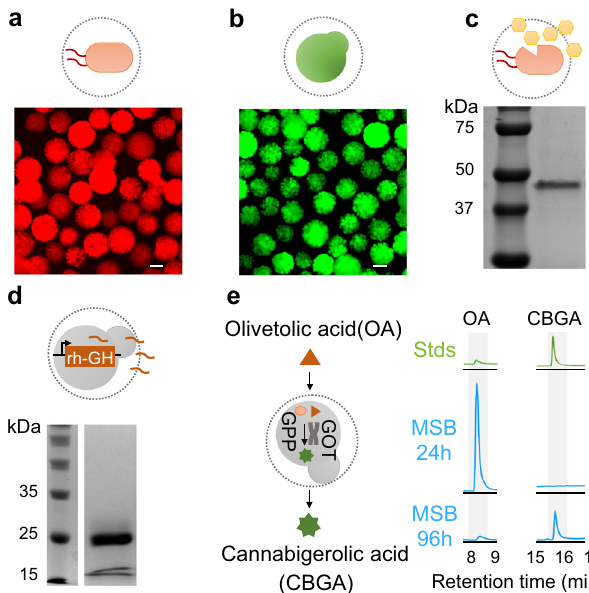
Fig. 2 Microbial swarmbot supported the growth of various microbes and produced versatile proteins and small molecules. a The growth of engineered E. coli was supported in microbial swarmbot (MSB). MG1655 cells (constitutively producing mCherry) were encapsulated in chitosan capsules and cultured in the SC + LB medium at 30 °C. Images were taken at 24 h. Scale bar = 200 μ m. b The growth of engineered S. cerevisiae was supported in MSB. BY4742 cells (expressing GFP under the TDH3 promoter) were encapsulated in chitosan capsules and cultured in the SC + LB medium at 30 °C. Images were taken at 24 h. Scale bar = 200 μ m. c MSB( E. coli ) produced the model protein through the programmed self- lysis of the cells. We used a density-dependent circuit (ePop) to program the autonomous lysis of the E. coli . MSB( E. coli ) (BL21(DE3) carrying the ePop circuit and the GFP-fused polypeptides expression circuit) were cultured for 24 h in M9 medium. The supernatant was collected for His- tagged resins puri fi cation. The resultant protein was veri fi ed by SDS-PAGE. Experiments were repeated independently more than three times with similar results. d MSB( P. pastoris ) produced a therapeutic protein through the engineered secretion. We created the circuit by fusing the sequence of recombinant human growth hormone (rh-GH) with α -factor signal for secretory expression. The circuit (driven by the AOXI promoter) was then linearized and integrated into the genome of P. pastoris X-33 by electroporation. We generated the MSB( P. pastoris ) and cultured them in the BMMY medium for 96 h. The supernatant was then collected, puri fi ed by His-tagged resins and veri fi ed by SDS-PAGE. Experiments were repeated independently more than three times with similar results. e MSB( S.